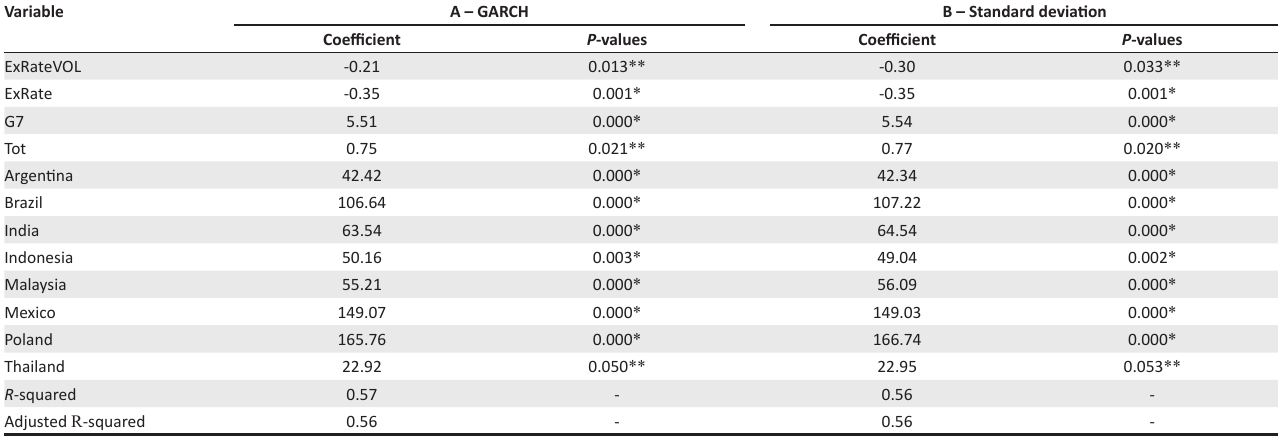
TABLE 8: LSDV estimation (dependent variable: exports). Variable